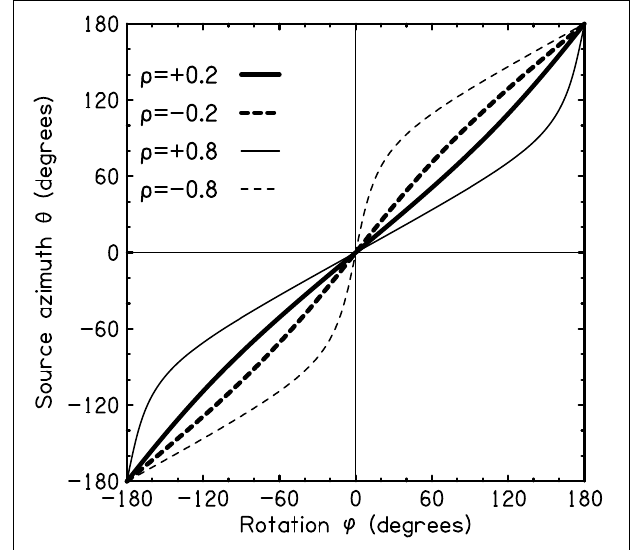
FIGURE A2 | Example calculation of the azimuth as a function of the head rotation angle for ρ = ± 0.2 (heavy line) and ρ = ± 0.8 (light line) for all possible values of the